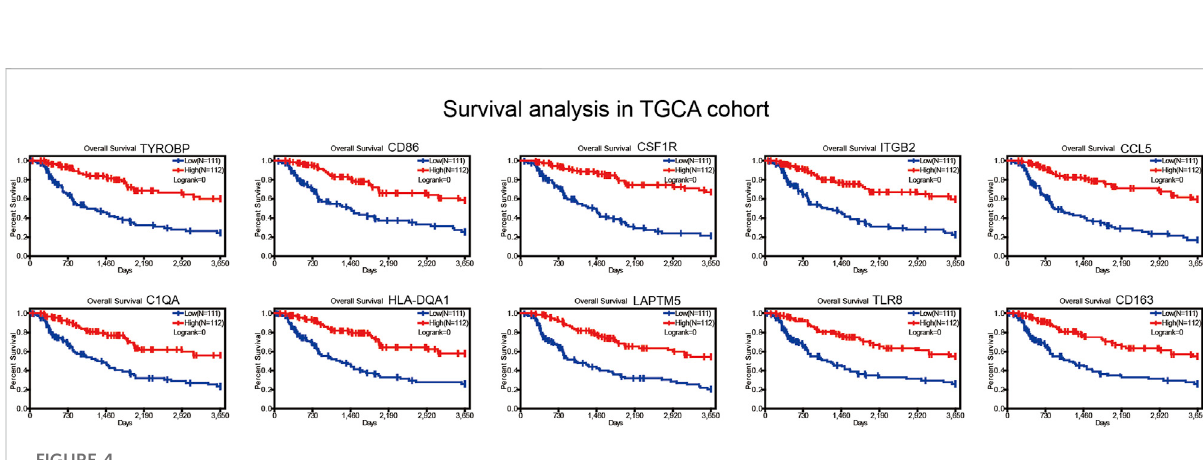
FIGURE 4 Survival curves for immune-related genes in TCGA